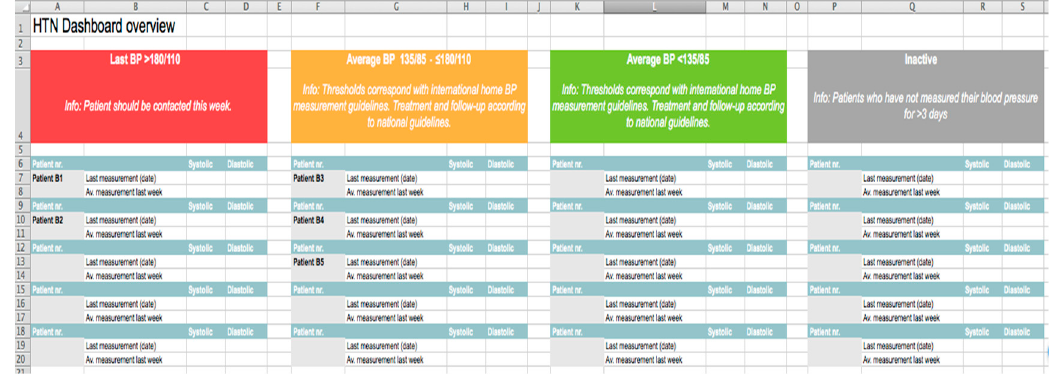
. Figure 2. Template of the dashboard for a single patient. Table 1. The key themes from patients’ interviews during the feasibility study. Themes